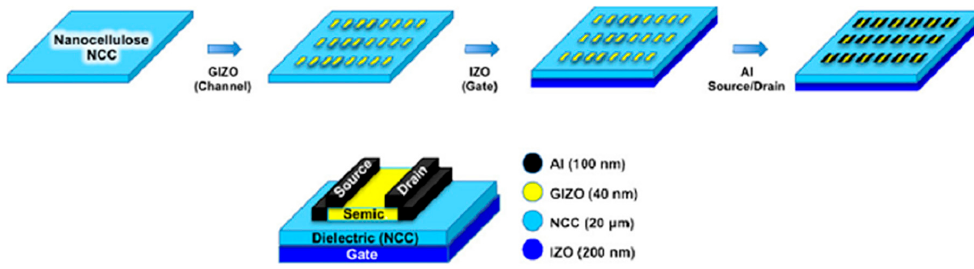
Figure 19. Schematics of the process of fabrication of FETs using NCC as the gate dielectric, and the corresponding staggered-bottom gate structure [140].